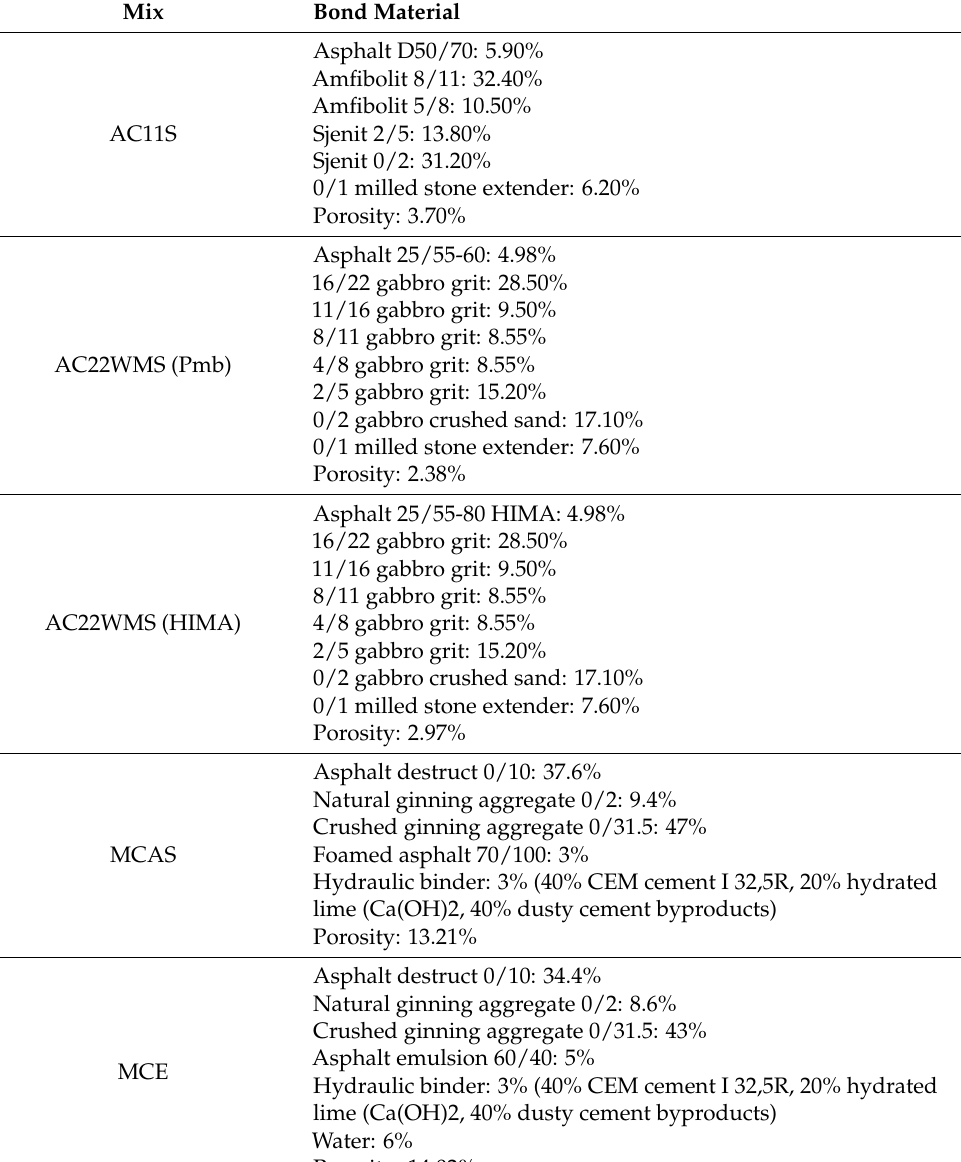
Table 1. Road mixes used in